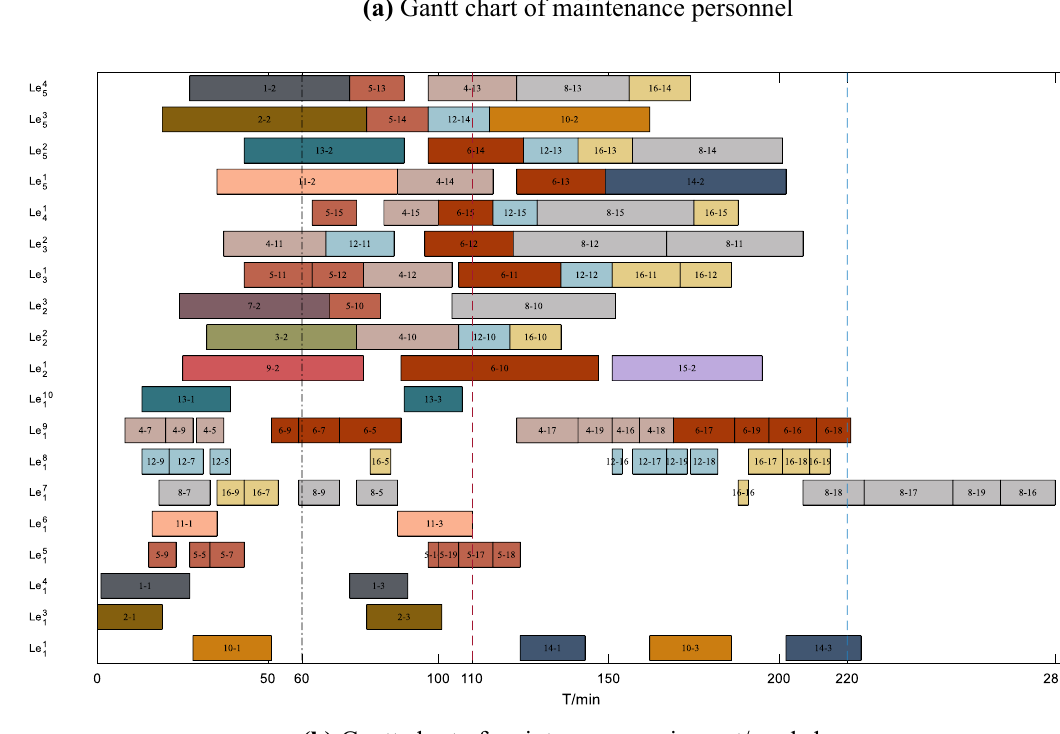
Fig. 17 Partial rescheduling of delay event III for 16 carrier-based